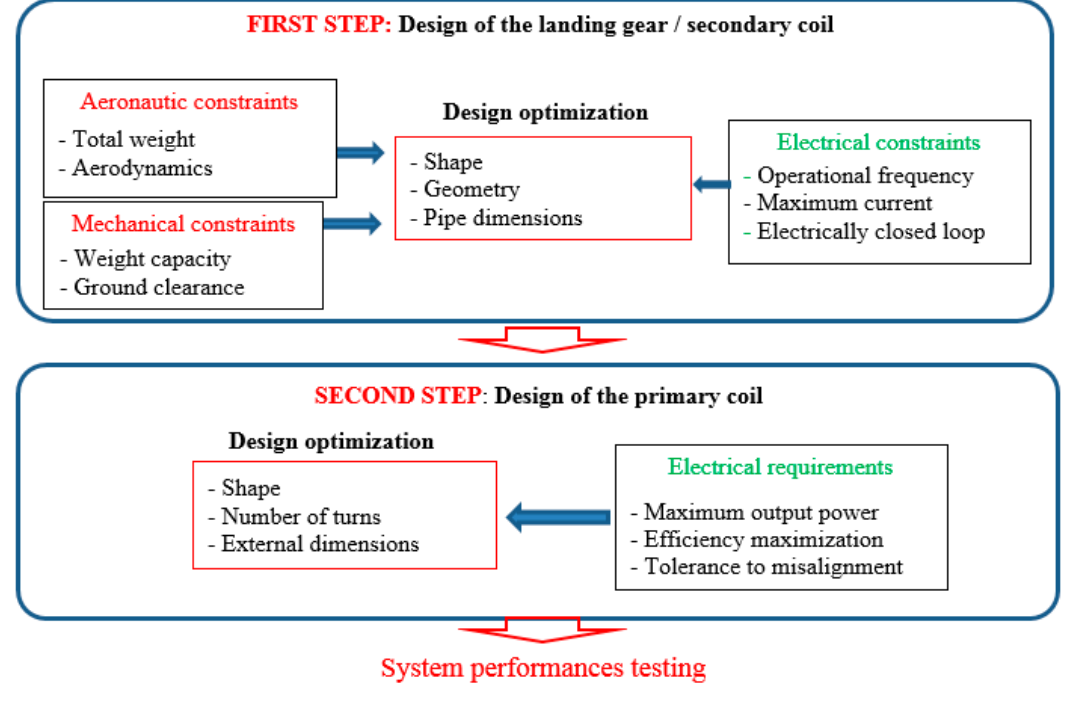
Figure 2. Block diagram of the proposed system design.